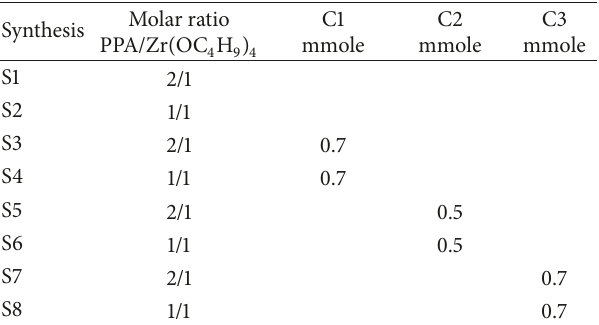
Table 1: Thequantities of materials used corresponding to syntheses S1–S8. Molar Synthesis